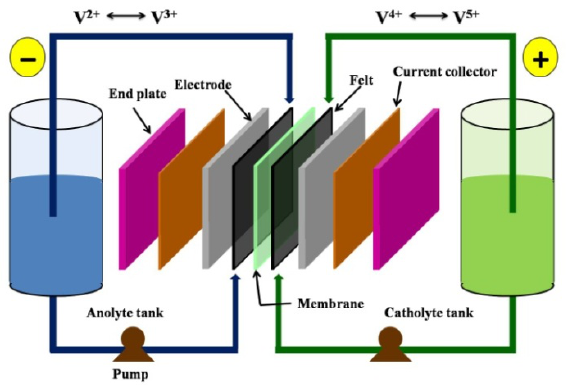
Figure 1. Schematic of a Vanadium redox flow battery (Adapted from